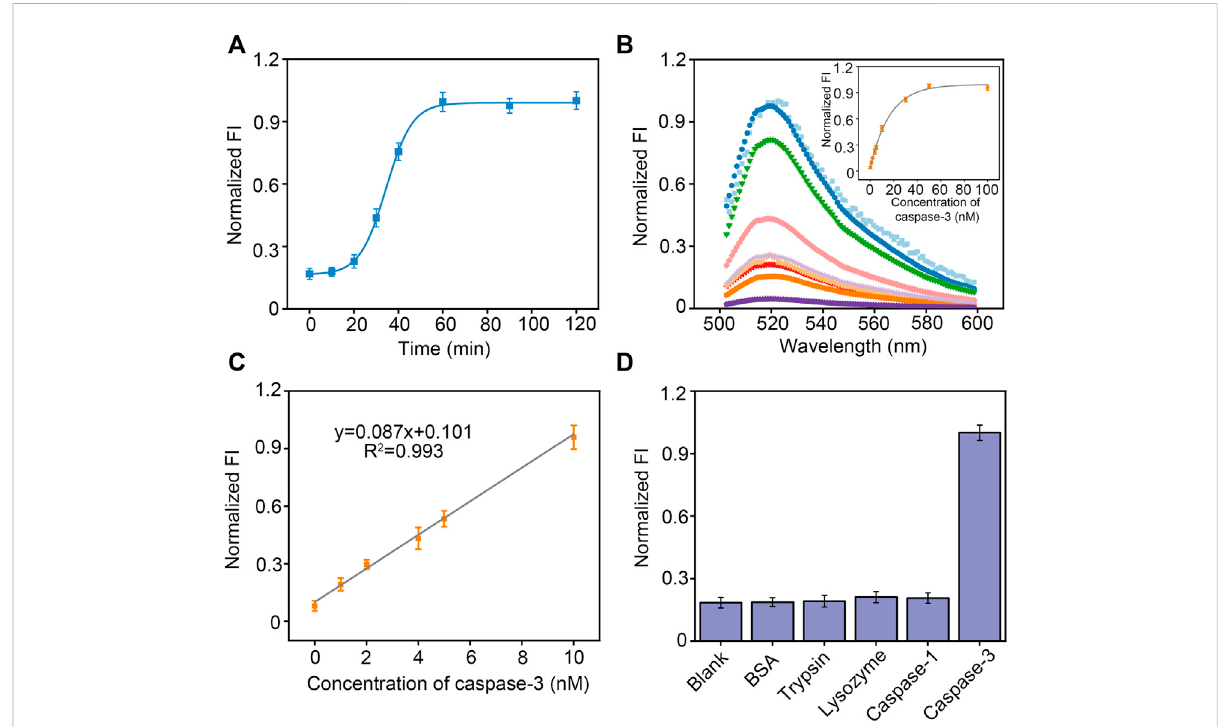
FIGURE 3 (A) Kinetic analysis for the caspase-3 using peptide-DNA hybrid bio-nanomicelles. (B) Fluorescence intensity curve with concentration of caspase-3. (C) Linearity of fl uorescence intensity with concentration of caspase-3. (D) Comparison of fl uorescence intensity in the presence of different protein and proteases. Excitation and emission wavelength of FAM is 492 and 522